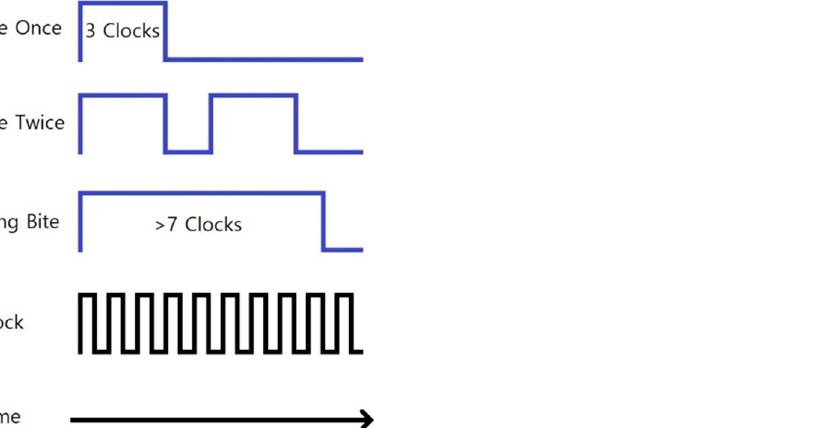
Figure 10. Classification of sEMG signals from three types of biting operation.